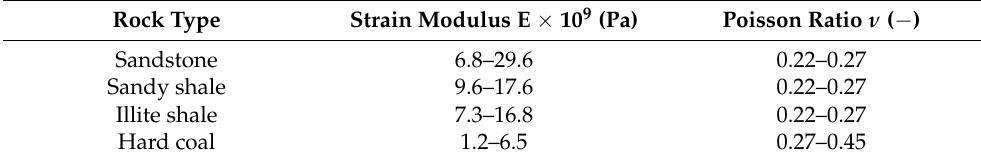
Table 1. Strain parameters of Carboniferous rocks.